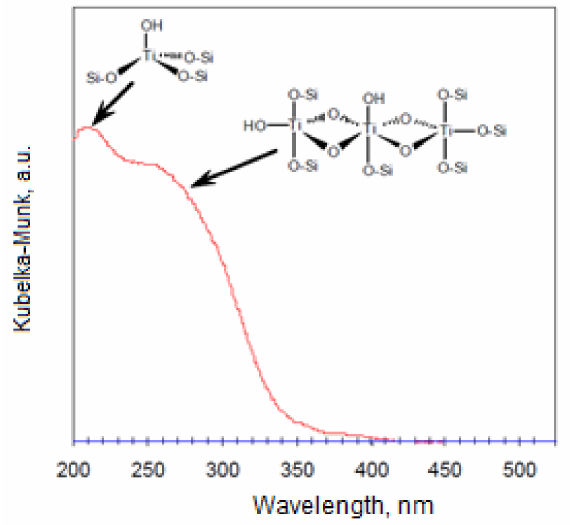
Figure 3. Diffuse reflectance UV-visible spectrum of TiO 2 –SiO 2 . Previously unpublished figure. TS-1 is the original titanosilicate [5,6]. This highly stable microporous material has an exceptional ability to catalyze the oxidation of many organic molecules, including sulfoxidation with aqueous H 2 O 2 [7–11]. However, since the Ti active sites are located inside of a channel system of about a 0.55 nm average diameter, the use of TS-1 is restricted to reactions of relatively small molecules [26,71]. Due to the TS-1 pore size/architecture and diffusion limitations, shape selectivity effects were observed in the reactions catalyzed by this material. For sulfoxidation reactions with H 2 O 2 on TS-1, we can distinguish three types of shape